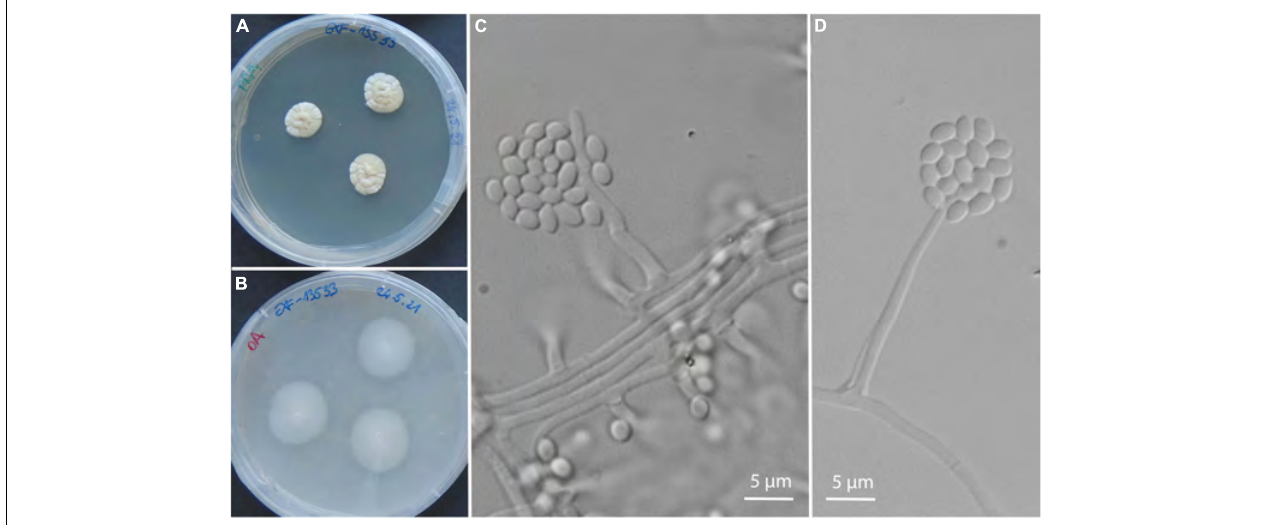
FIGURE 5 | A new species of the genus Acremonium isolated from olms in captivity: from several asymptomatic and from a single symptomatic animal. Culture of EXF-13533 on PDA (A) , on OA (B) ; micromorphology of the strain EXF-14260 on PDA (C,D) .